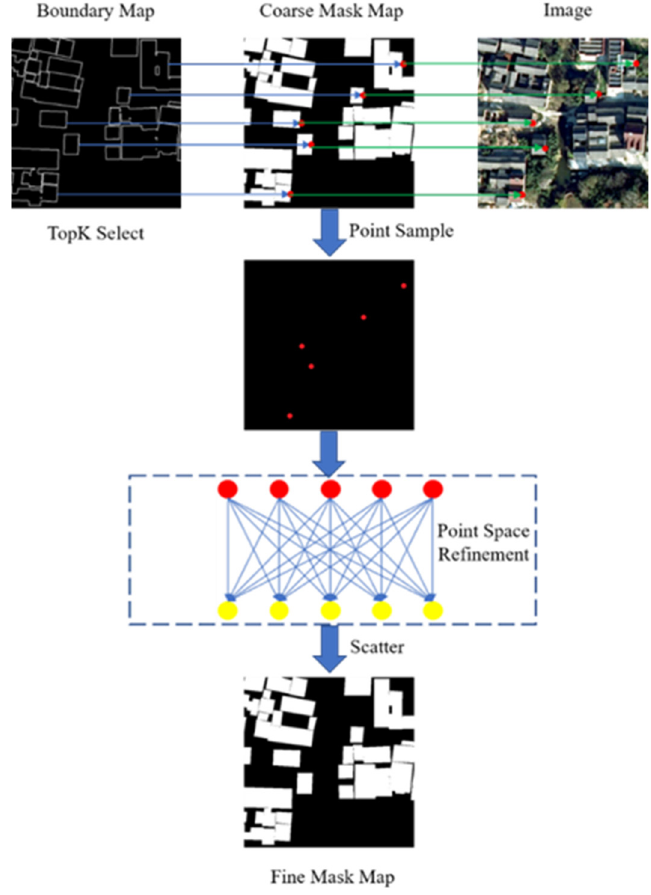
Figure 4. Point-to-point module (PTPM).